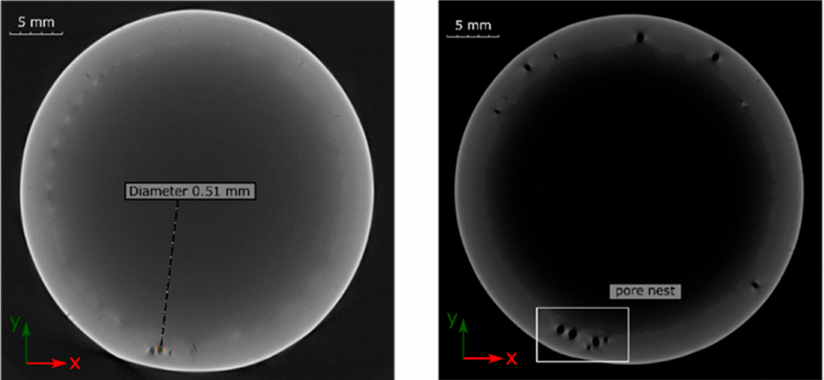
Figure 11. CT images of laser beam-welded specimens: ( a ) IN625_WOHT_SLME—group B and ( b ) IN718_WOHT_SLME—group